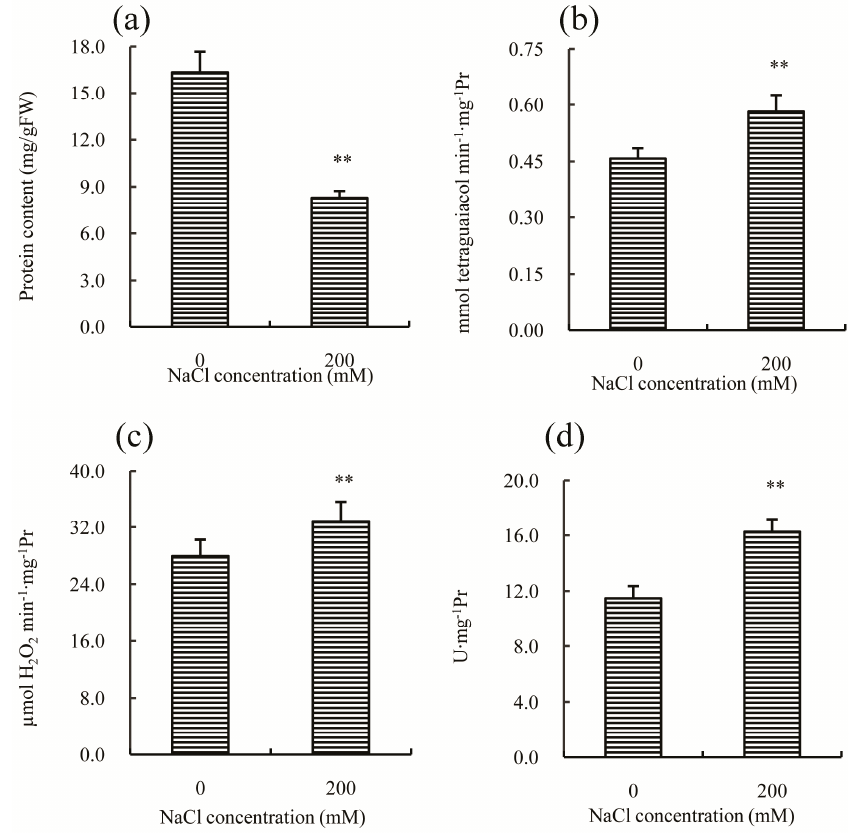
Figure 4. Effects of 200 mM NaCl stress on: the soluble protein content ( a ); and the enzyme activities of: POD (peroxidase) ( b ); CAT (catalase) ( c ); and SOD (superoxide dismutase) ( d ), in the leaves of Chinese cabbage seedlings. All parameters were measured on Day 30 after salt treatment. The values are the means ( ± SD) of five replicates. ** Indicate p < 0.01.